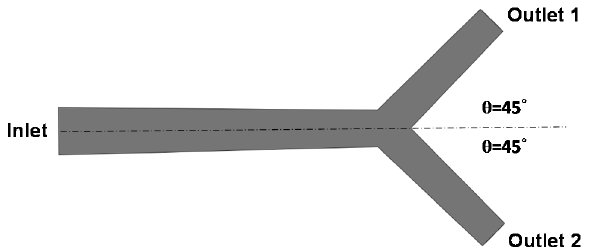
Figure 4. Hepatic artery bifurcation model for the computational fluid dynamics (CFD) simulation.